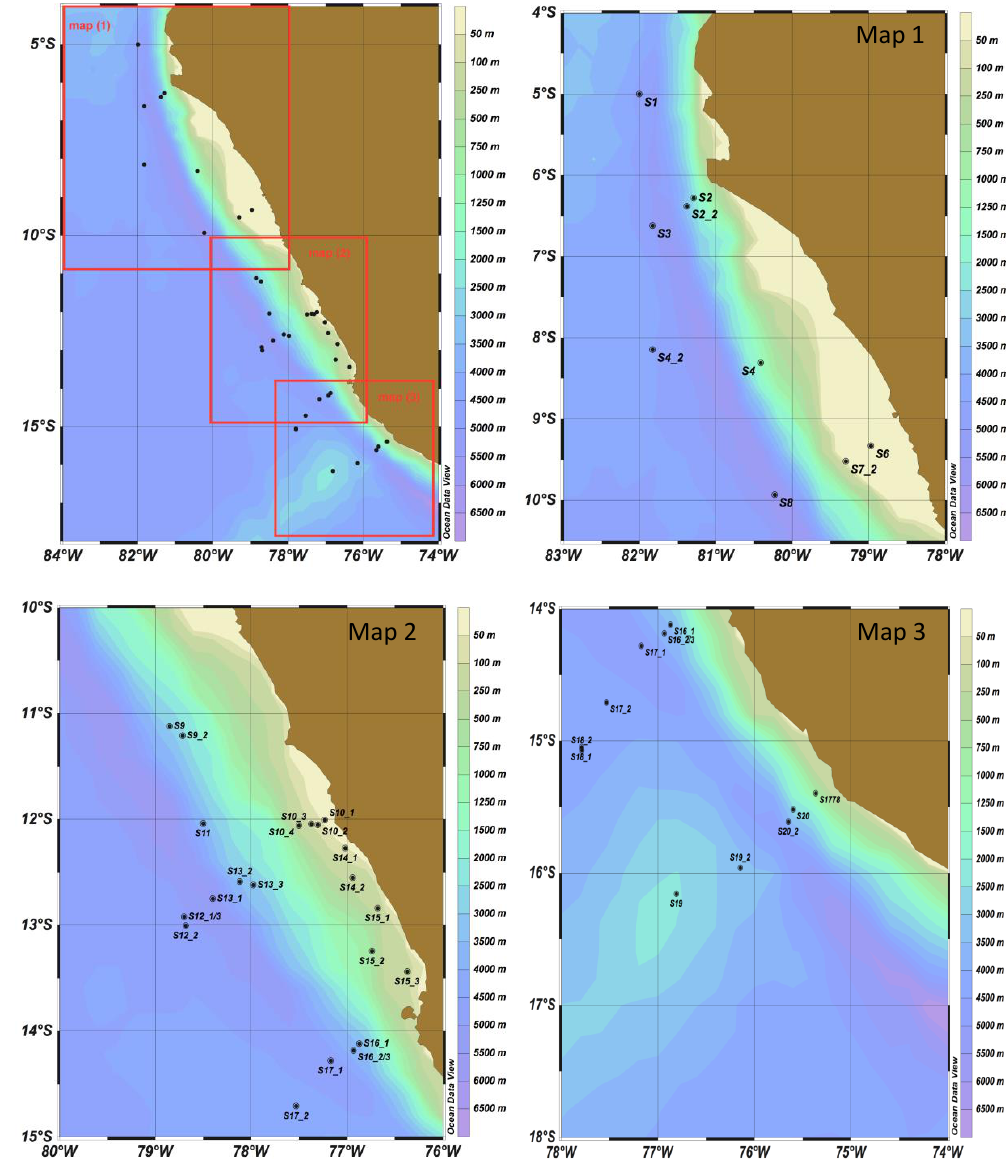
Figure 1. Maps of stations where sampling for the sea-surface microlayer (SML) and underlying seawater (ULW) was conducted during the SOPRAN Meteor 91 cruise along the coastal upwelling area off the coast of Peru in